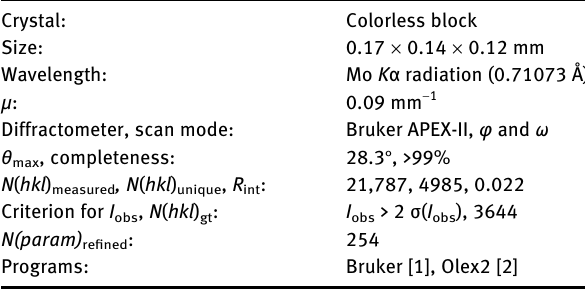
Table  : Data collection and handling. Crystal: